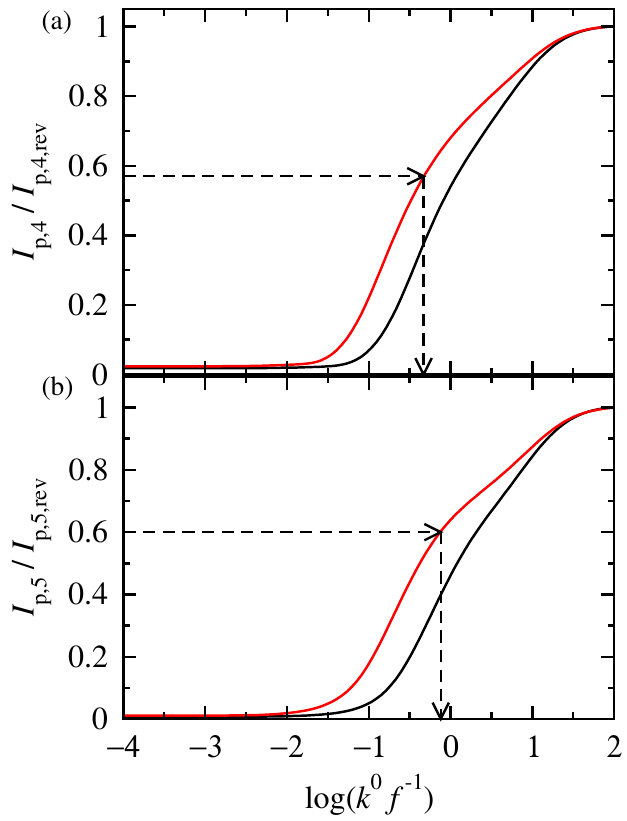
Figure 6. Computational results: Dependence of the normalised principal peak height for the ( a ) 4th and ( b ) 5th harmonic of an immobilised species. Parameters: a = 0.5 and A 0 = 0.2 (black) and 0.25 V